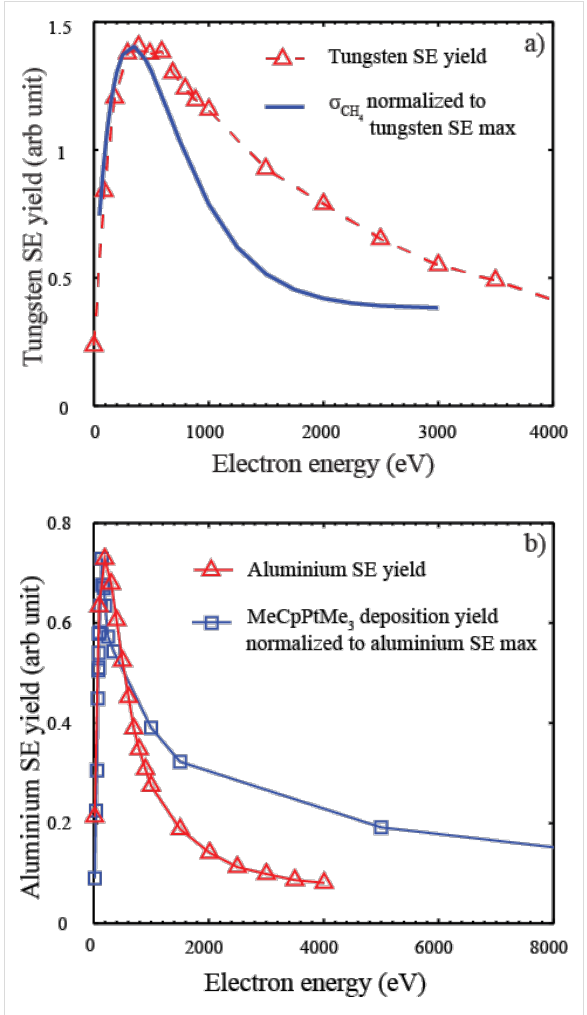
Figure 11: a) A line of best fit to the cross section for methane desorp- tion from MeCpPtMe 3 adsorbed on a gold surface ( Z = 97) and exposed to electron irradiation in the energy range from 0 to about 3000 eV (solid blue line), compared to energy dependence of the SE yield of tungsten ( Z = 94) as a function of primary electron energy (red triangles). b) The deposition yield of MeCpPtMe 3 on a silicon surface ( Z = 14) as a function of the PE beam energy in the range from about 0–5000 eV (blue squares) compared to the energy dependence of the SE yield from aluminum ( Z = 13) as a function of primary electron energy (red triangles). The methane desorption cross sections (a) are adapted from Wnuk et al. [68] and the deposition yield (b) is adapted from Botman et al. [12]. The calculated SE yields are adapted from Ohya et al. [8] (using the partial wave expansion for the cross-section). Lines connecting the symbols are only meant to guide the